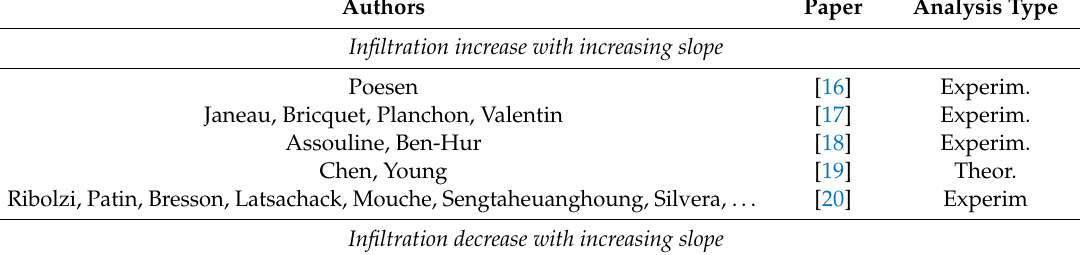
Table 1. Studies dealing with the relation between slope and